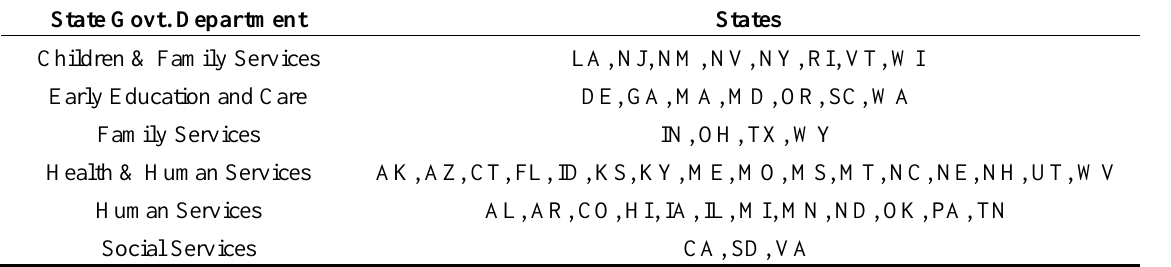
Table 2. Departments responsible for regulating day care in different states.